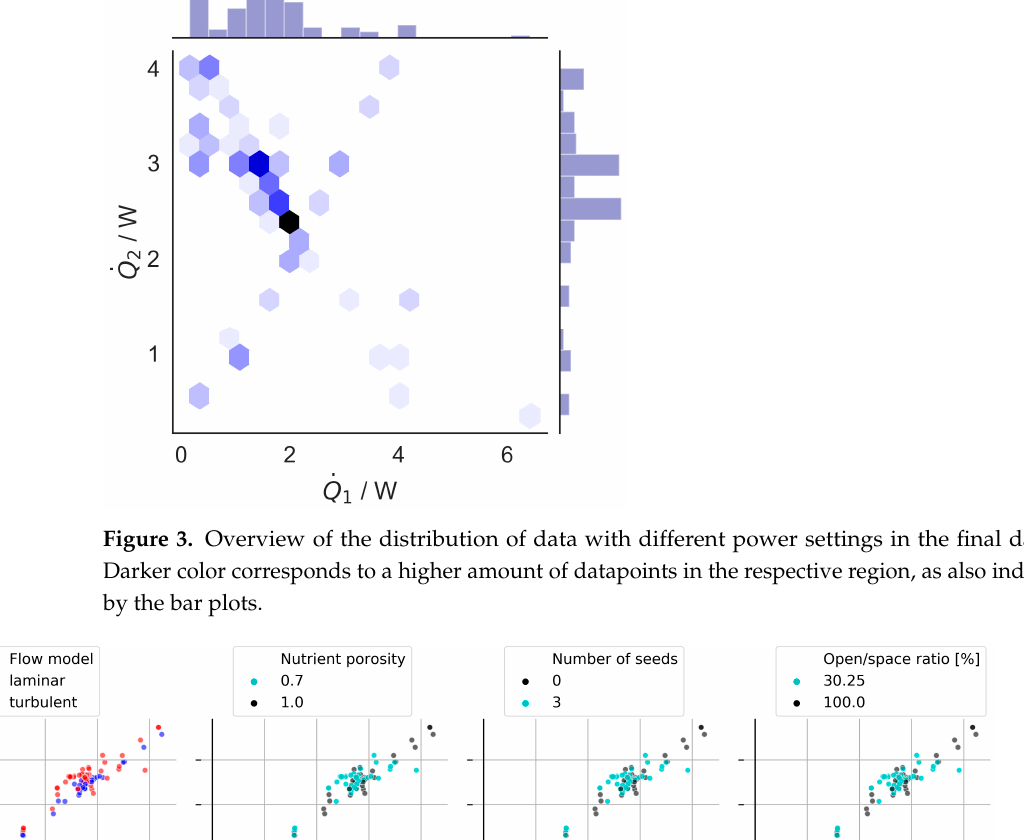
Figure 3. Overview of the distribution of data with different power settings in the final dataset. Darker color corresponds to a higher amount of datapoints in the respective region, as also indi- cated by the bar plots.